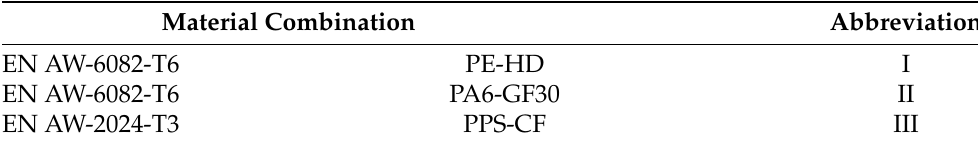
Table 1. Overview of the material combinations and the abbreviations used in this